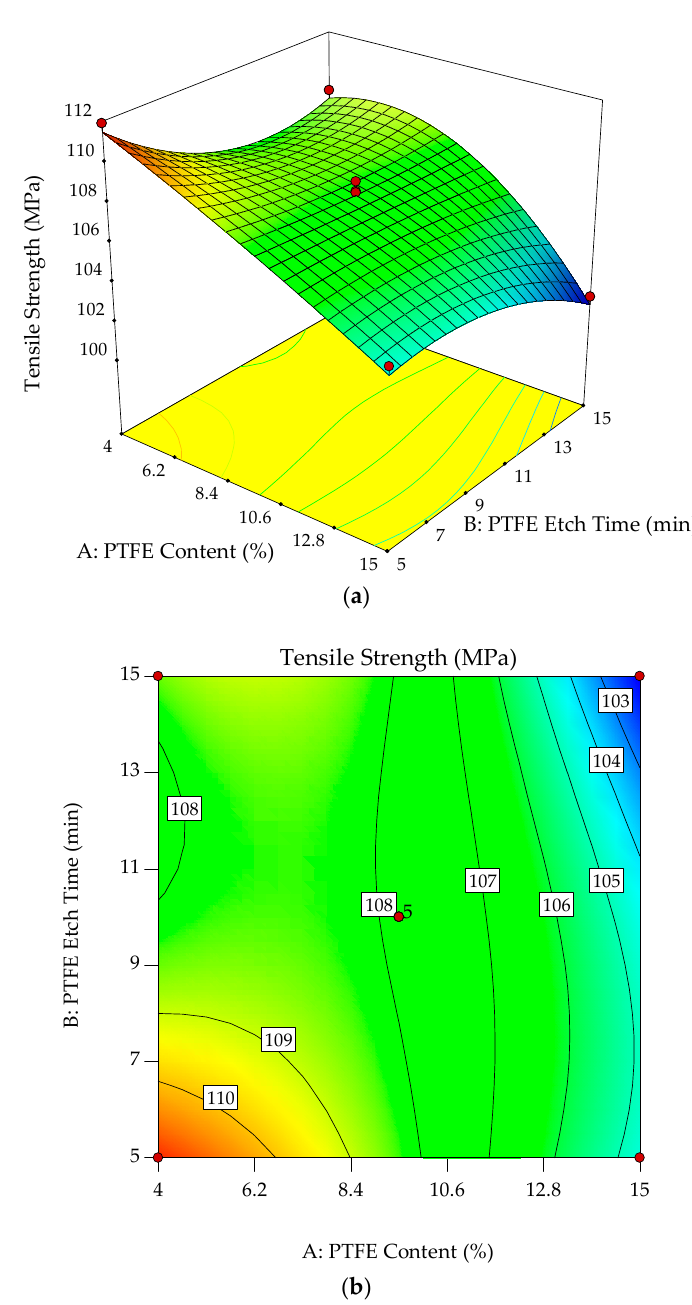
Figure 5. 3D response surface plot ( a ) with 2D contour plot; ( b ) of the effects of PTFE content and PTFE etch time on tensile strength of POM composites.